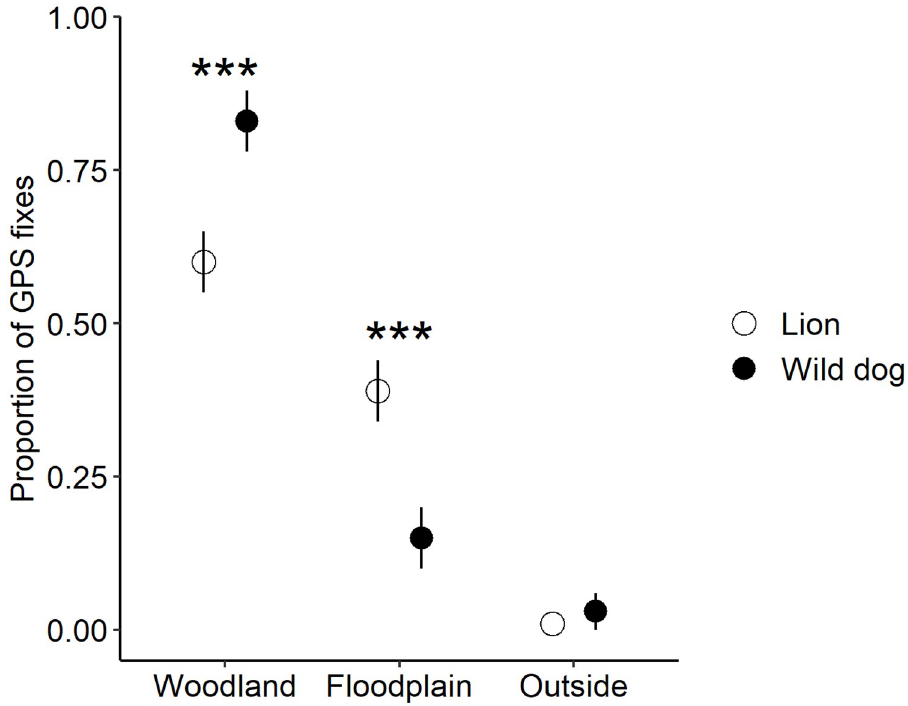
Fig 6. The difference in woodland and floodplain habitat use by wild dogs and lions in Gorongosa National Park between June 2018 and September 2020. Error bars represent intergroup variation in the proportion of GPS fixes while three stars indicate highly significant differences (i.e. p < 0.001) in habitat use between and within these two carnivore species.